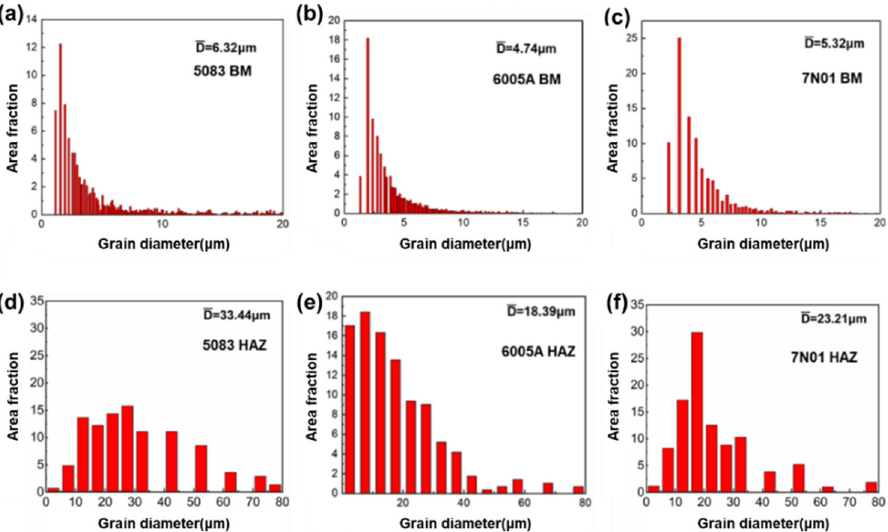
Figure 8. The grain size of different aluminum alloy welded joints: 5083: ( a ) BM; ( b ) HAZ; 6005A: ( c ) BM; ( d ) HAZ; 7N01: ( e ) BM; ( f ) HAZ.